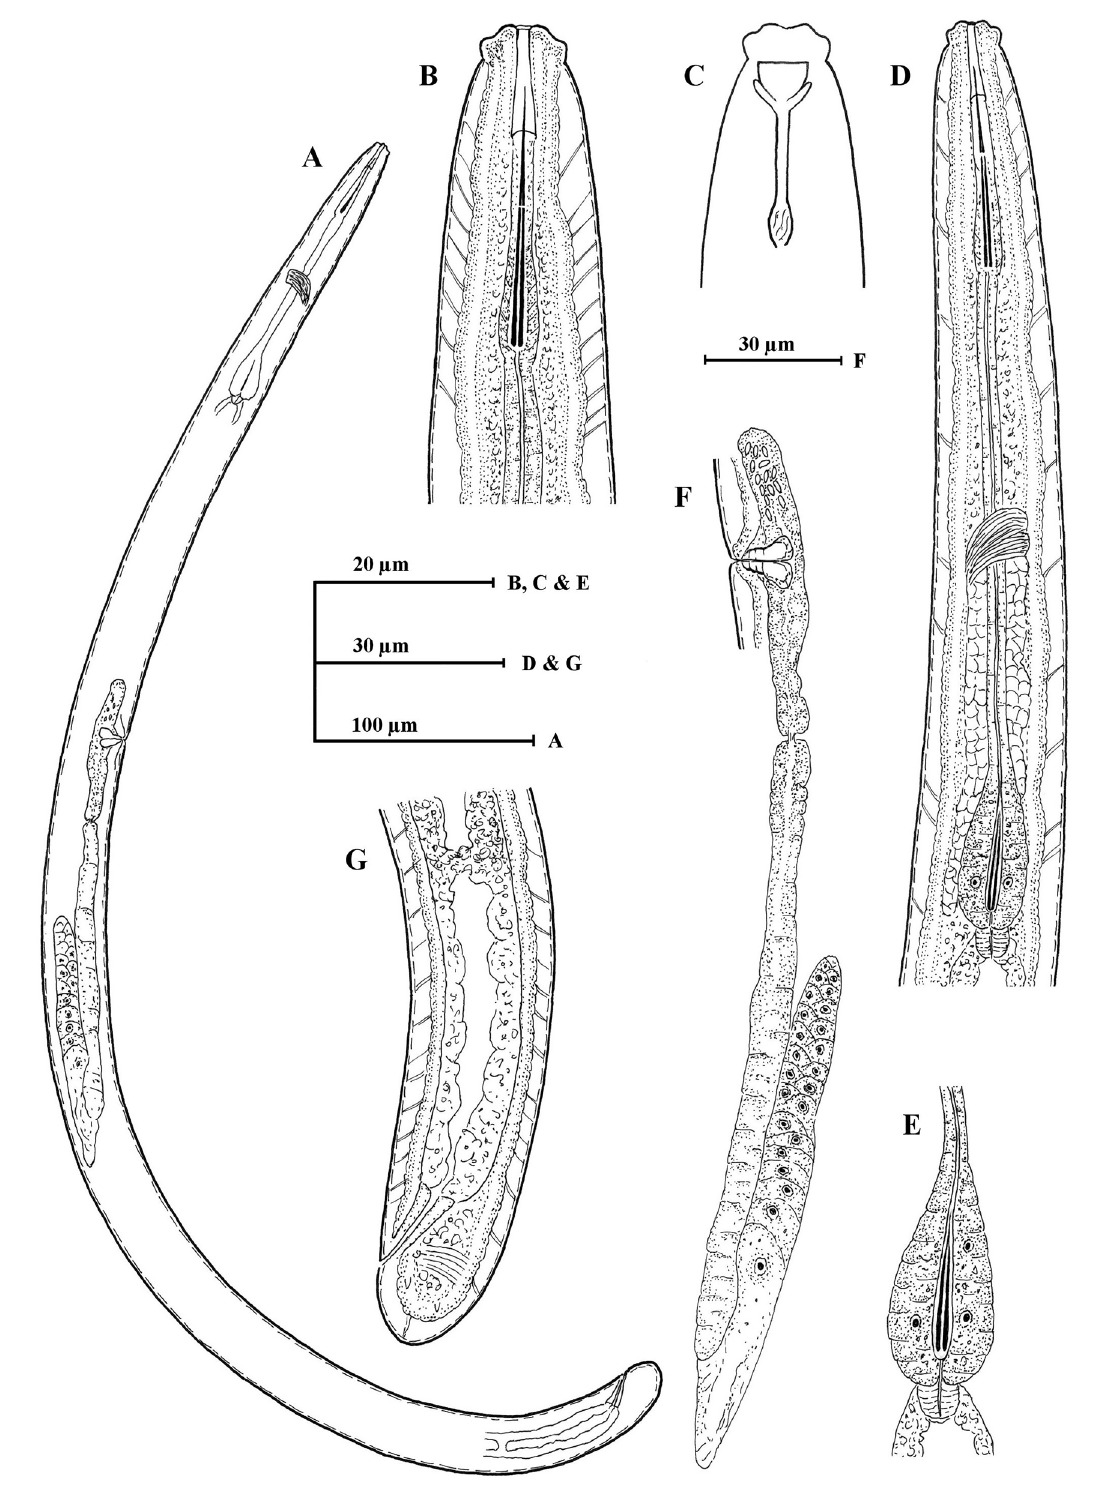
Fig. 12. Basirotyleptus goaensis sp. nov., ♀. A–E, G . Paratypes (AMU/ZD/NC/ Basirotyleptus goaensis /2–6). A . Paratype 7. B, D, G . Paratype 4. C . Paratype 2. E . Paratype 1. F . Holotype (AMU/ ZD/NC/ Basirotyleptus goaensis /1). A . Entire specimen. B . Anterior region. C . Anterior region showing amphid. D . Pharyngeal region. E . Pharyngeal bulb. F . Genital system. G . Posterior